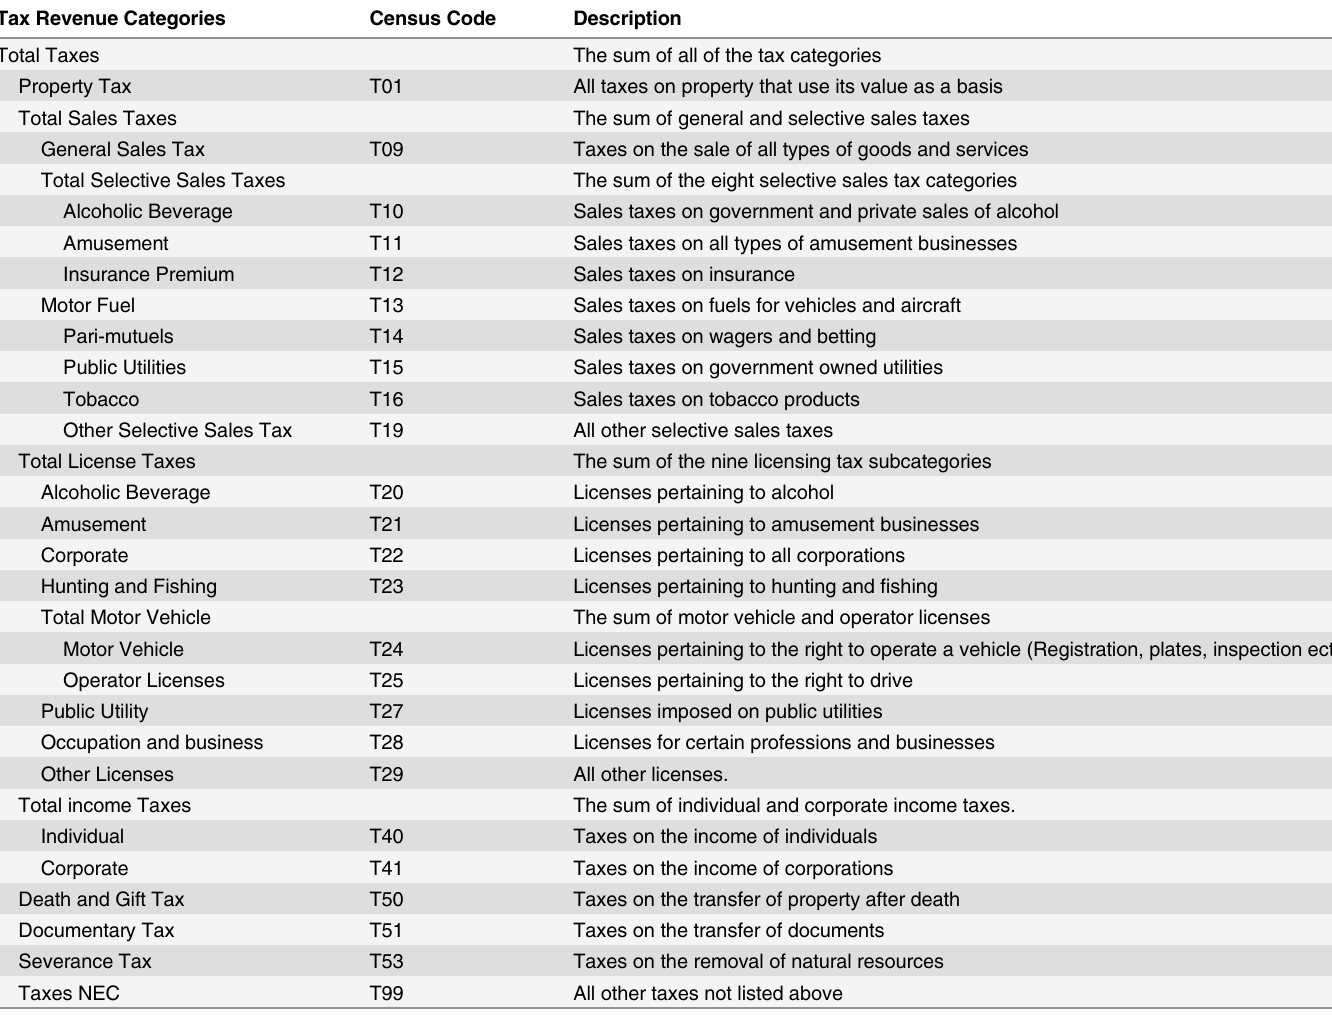
Table 2. Tax Revenue